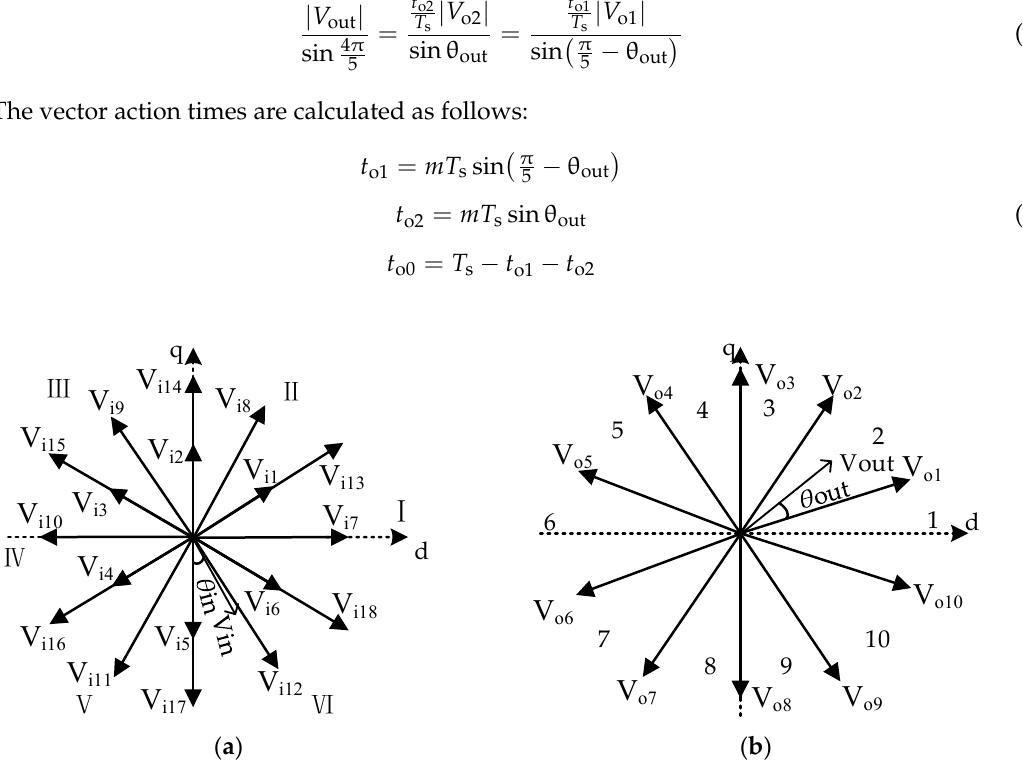
Figure 4. Vectors of 3 × 5 M3C ( a ) Vectors of input side; ( b ) Vectors of output side.